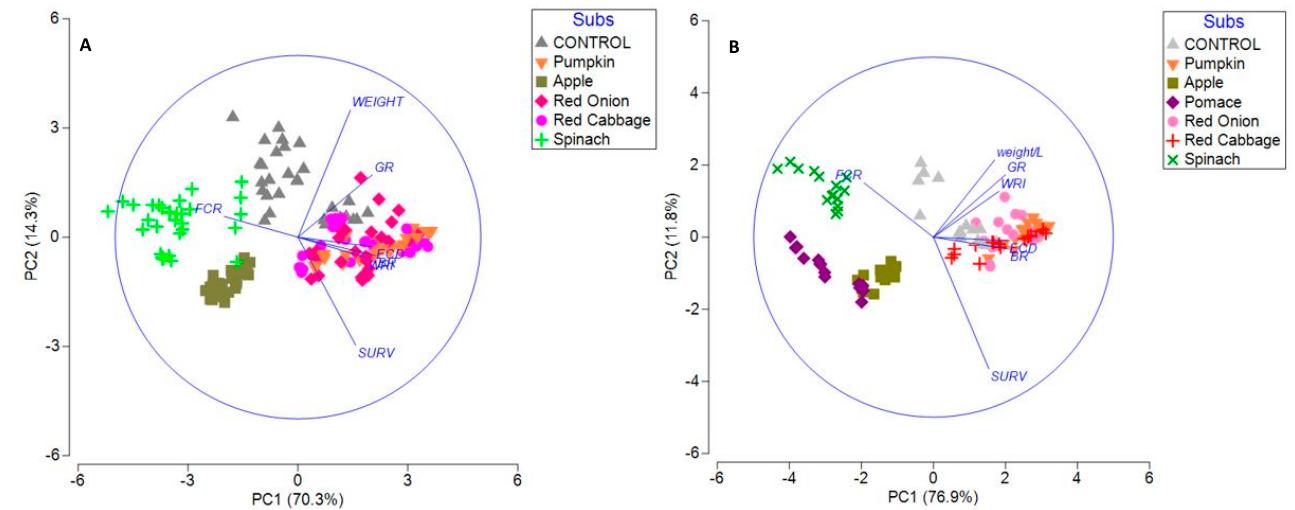
Figure 3. Principal component analysis loading plots for black soldier fly performance and conversion parameters calculated (WRI—waste reduction index; FCR—fed conversion ratio; BR—bioconversion ratio; ECD—efficiency of conversion of digested feed; GR—growth rate). ( A )—All conditions (without grape pomace); ( B )—70% SM (all substrates).